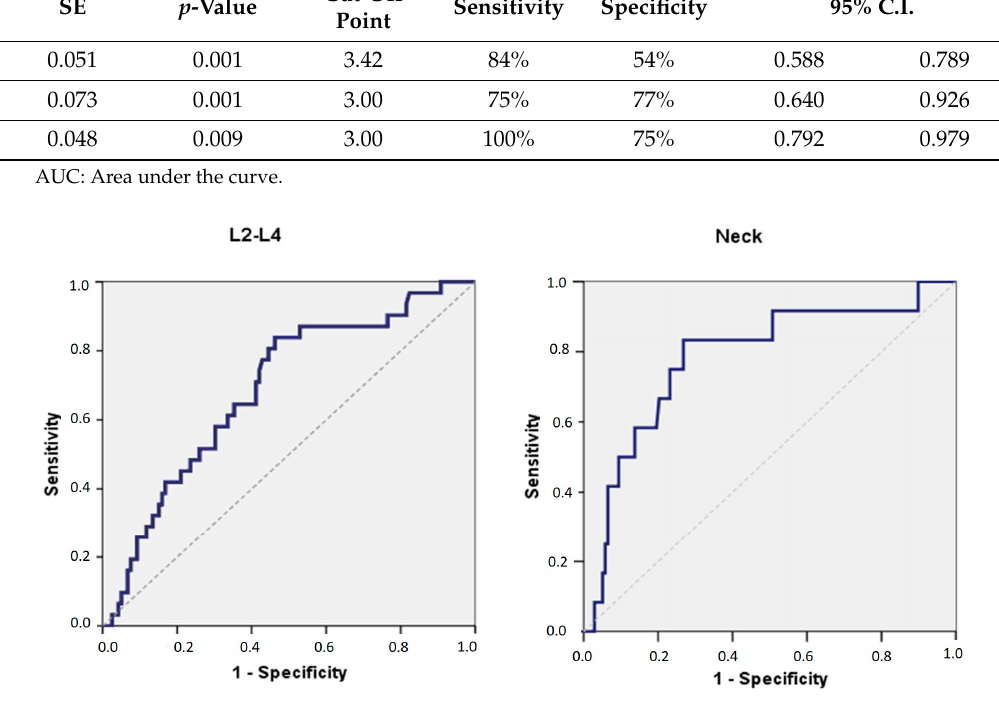
Figure 3. Receiver operator characteristic (ROC) curves of mandibular cortical width (MCW) with T-score for the lumbar spine(L2–L4) and the femoral neck, respectively. If an individual’s age at menarche was above 14 years old, she had 80% less probability of developing osteoporosis, and if MCW was less than 3.4, the individual had 3.9 times greater probability of developing